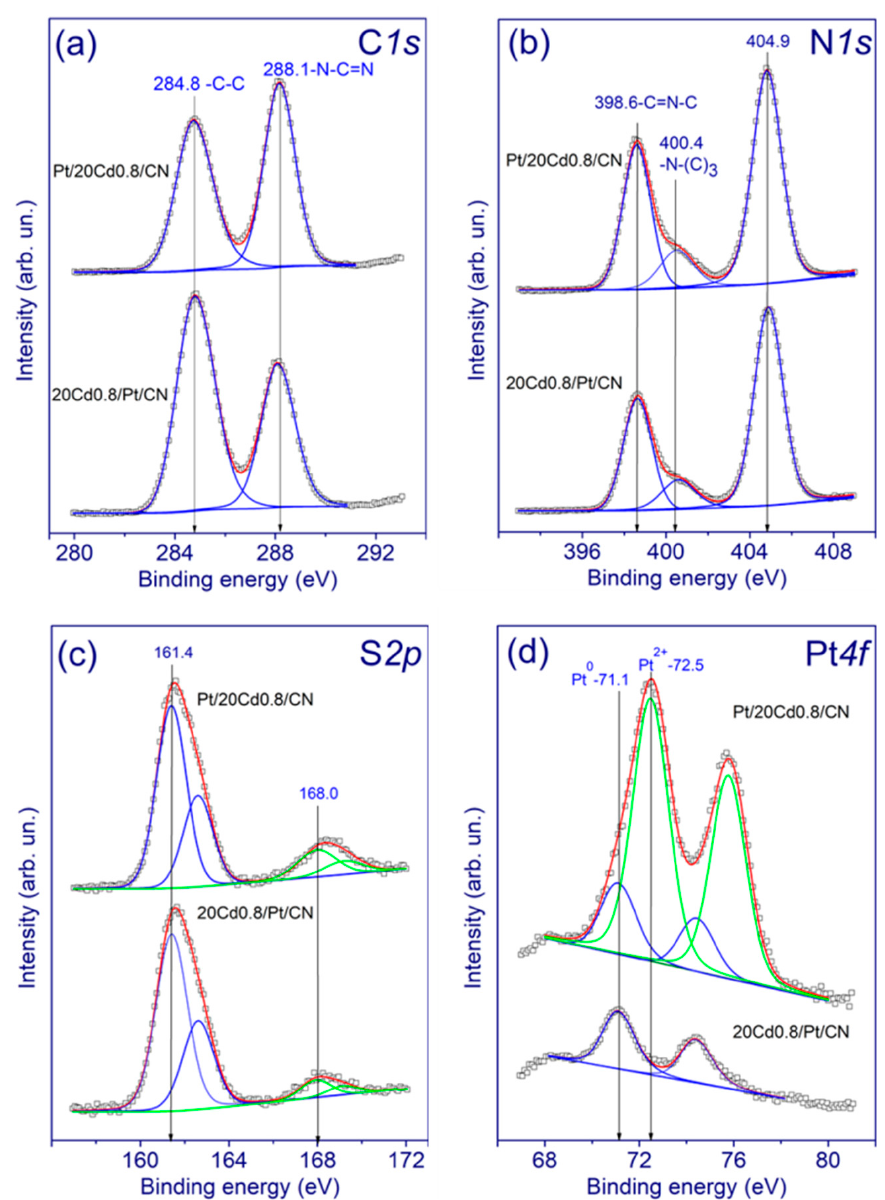
Figure 3. The C 1s ( a ), N 1s ( b ), S 2p ( c ), and Pt 4f ( d ) XPS spectra of the photocatalysts Pt/20Cd0.8/CN and 20Cd0.8/Pt/CN.